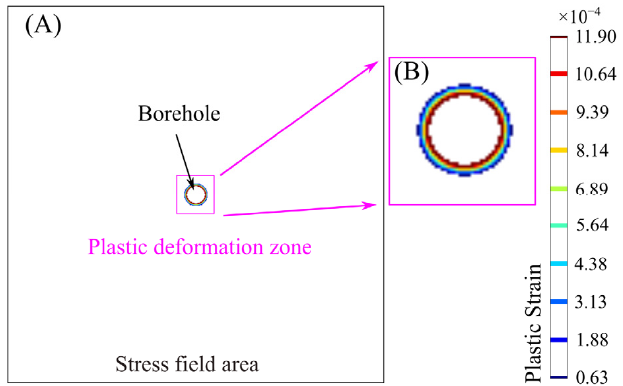
Figure 6. Cloud map of plastic strain around the borehole calculated from the damage model. ( A ) Plastic deformation zone around the borehole. ( B ) Enlarged view.